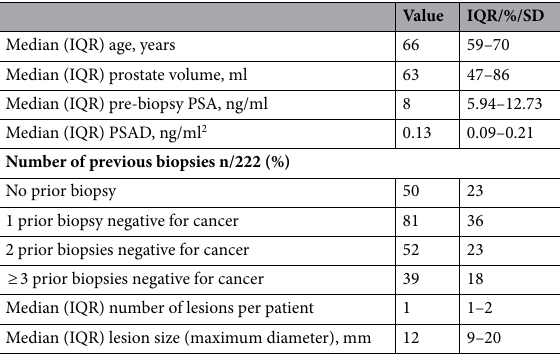
Table 1. Patient demographics, clinical characteristics and mpMRI findings (n =